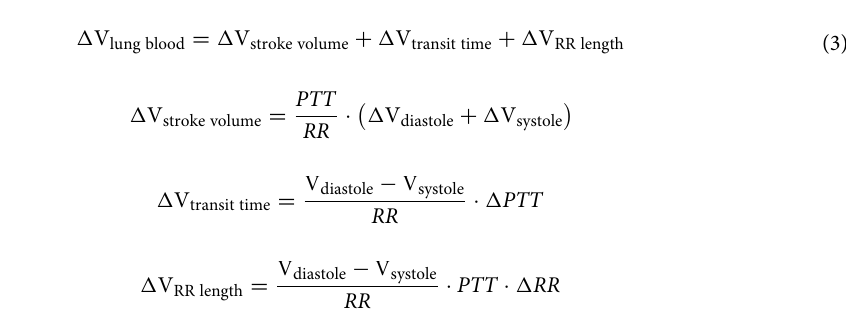
Figure 1. Cine sequences of the heart of a mouse in diastole and systole: four chamber view, two chamber view and a series of short axis views of the left ventricle used for volumetric